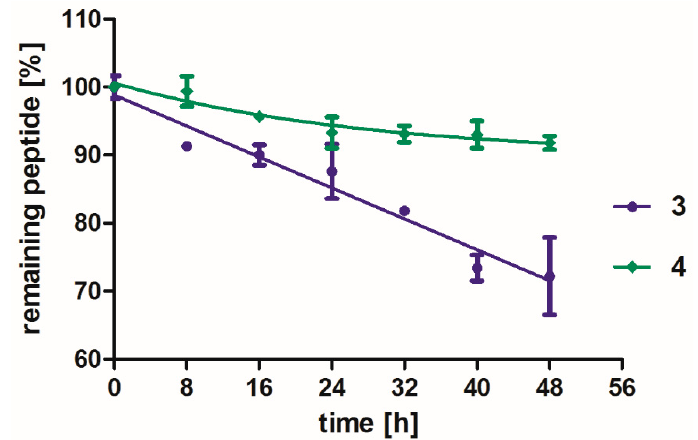
Figure 8. In vitro stability toward proteolysis of two triazolopeptides 3 violet line and 4 green line. Each point is an average result ± SD calculated from three independent experiments.